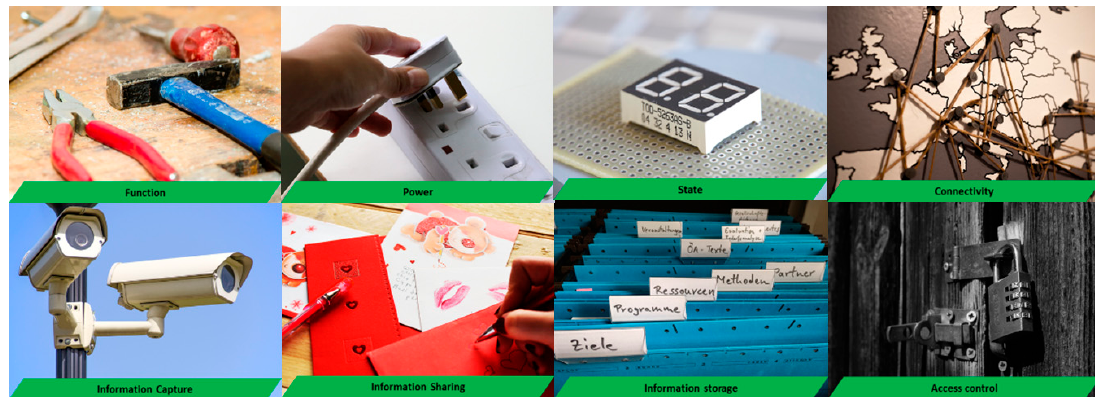
Figure 4. IoT properties cards (front side).